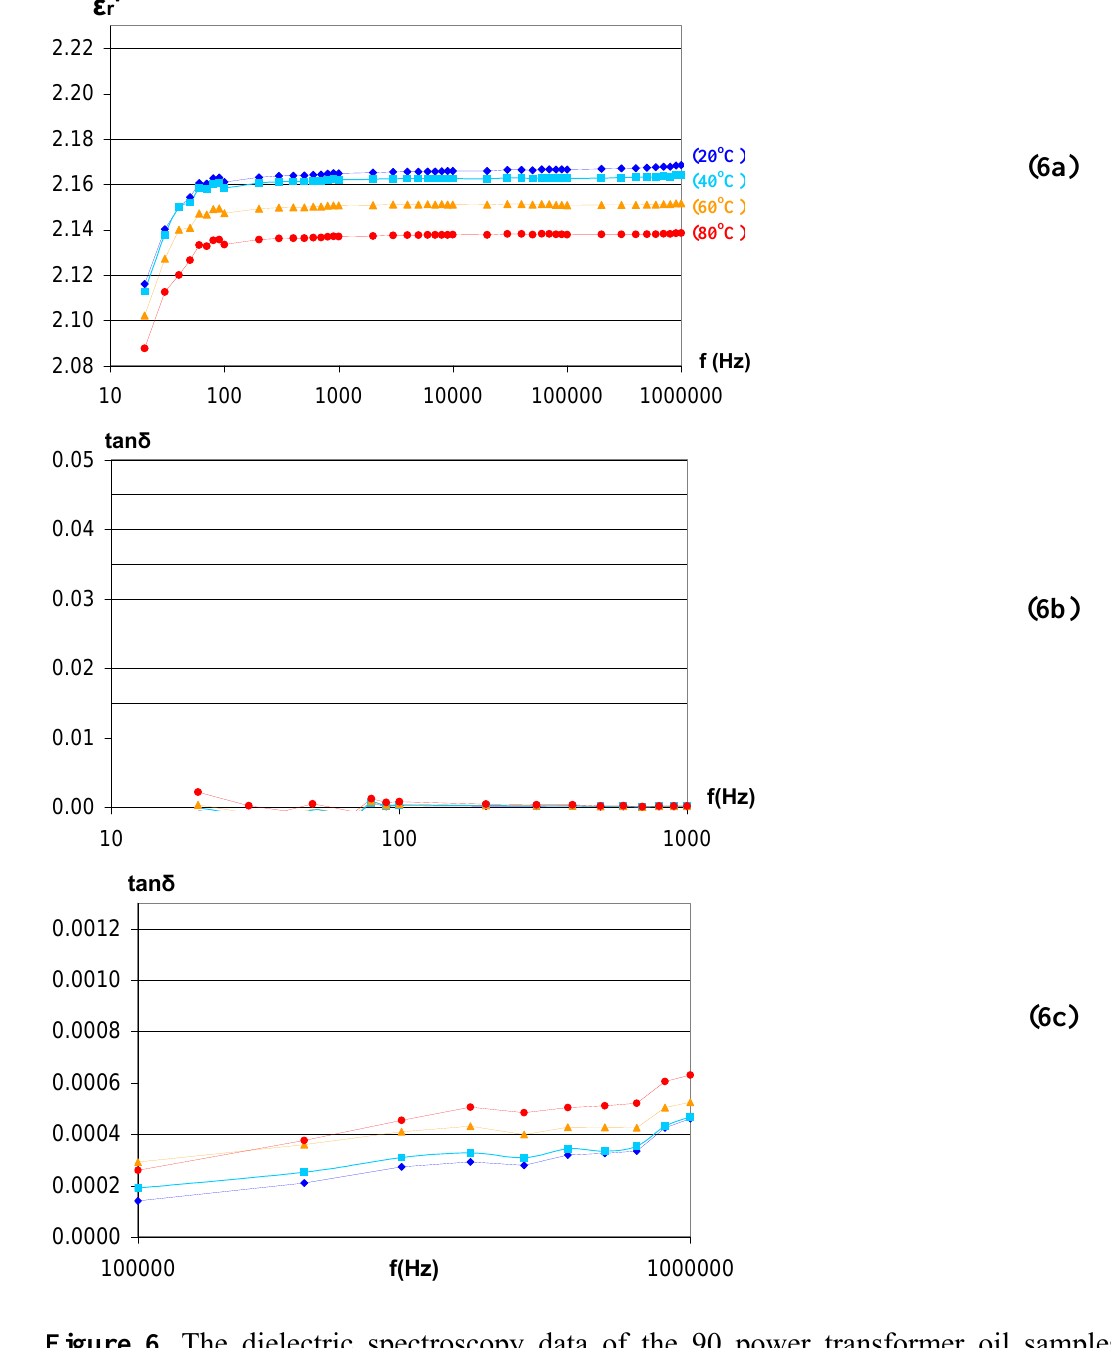
′ ) of all Group-I samples, as a r